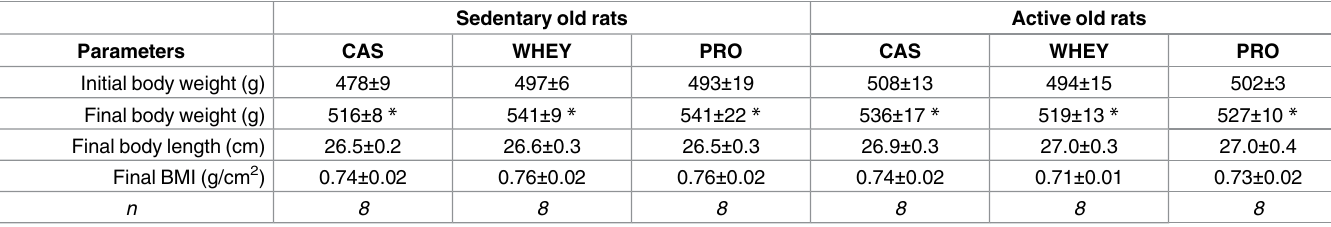
Table 3. Similar body weights and final morphometric parameters after protein supplementation in sedentary or active old rats. Sedentary old